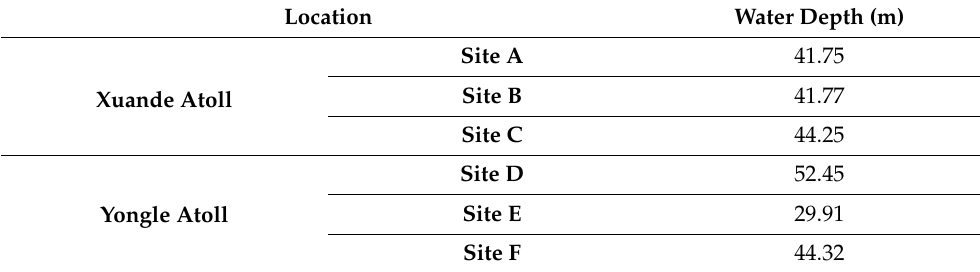
Figure 13. Reference sites near the Xuande and Yongle Atolls in the Xisha Islands. Table 3. Information of six selected near-island locations for wave characterization.